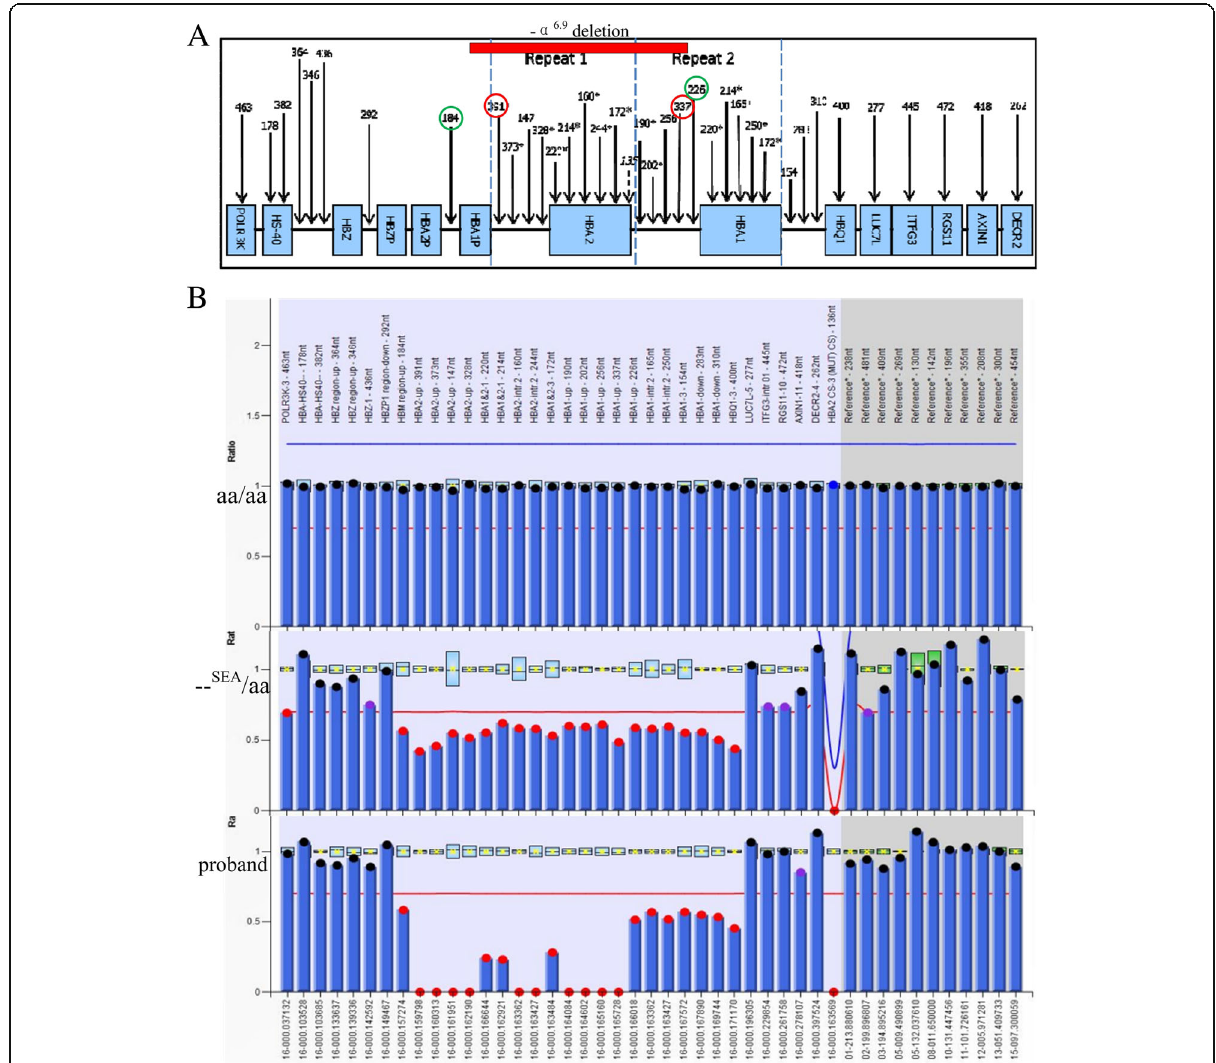
Fig. 2 Multiplex ligation-dependent probe amplification assay results. a The corresponding position of amplification products (number unit in bp) and α -globin gene cluster (NG_000006.1) sequence in the P140-C1 HBA kit (MRC-Holland). b The corresponding fragment ratio of MLPA results from the αα / αα , -- SEA / αα and proband. X-axis is the product fragment length (bp), while Y-axis represents their ratios. According to the manufacturer ’ s instructions, probe ratios between 0.7 and 1.3 are defined as